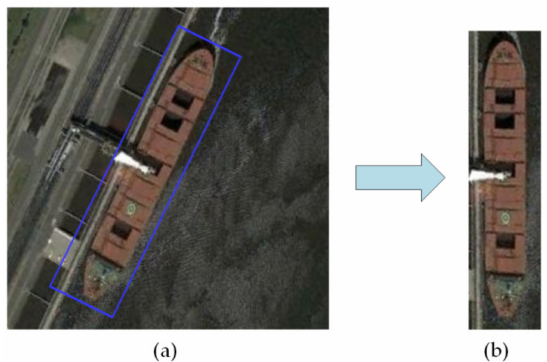
Figure 6. Using affine transformation to extract ship target-level image. ( a ) is the object positioning image p ( x , y ) ; ( b ) is the target image. Affine transformation can reduce the background information interference in the target